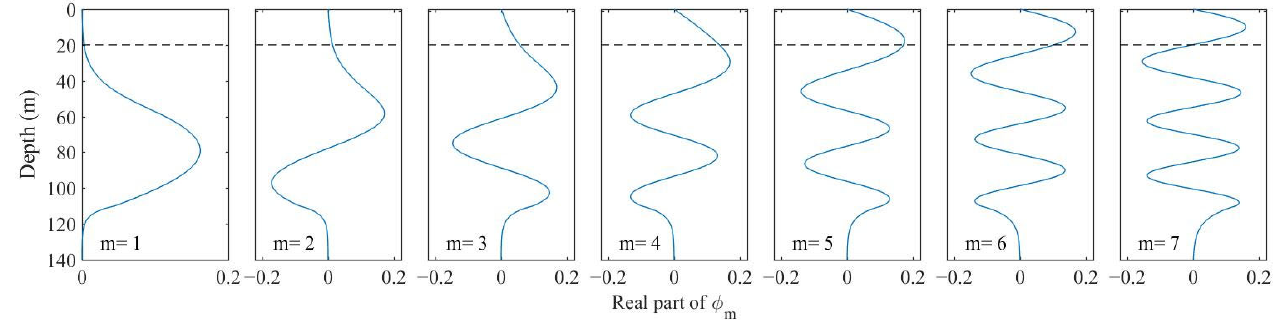
Figure 18. Real part of the local mode eigenfunctions ∅